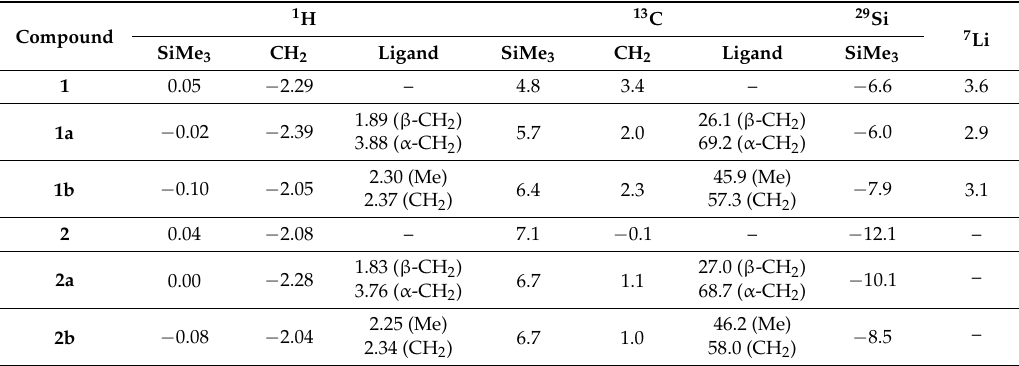
Table 4. 1 H, 13 C, 29 Si, and 7 Li NMR spectroscopic data of compounds 1a , b and 2a , b dissolved in C 6 D 12 . The corresponding data of compounds 1 and 2 are added for comparison. The ligand is THF or TMEDA, respectively. The chemical shifts are given in ppm.